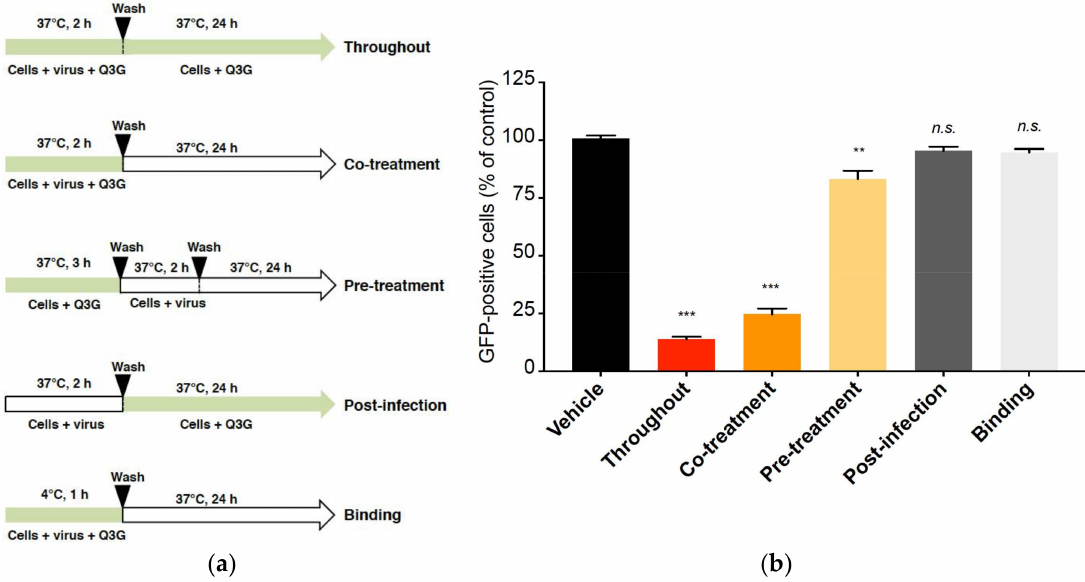
Figure 4. Q3G targets early stages of ZIKV infection. In ( a ), schematic representation of synchronised ZIKV GFP infection and Q3G treatment assays in A549 cells. Q3G (100 µ M) or vehicle were used for treatment of A549 cells throughout the infection (throughout), concurrently to virus input (co-treatment), pretreatment of naïve cells (pre-treatment), after virus exposure (post-infection) with specific washing steps and incubation periods. For viral attachment assay (binding), the test samples were used to treat A549 cells concurrently with ZIKV GFP at 4 ◦ C before washing and shifting the temperature to 37 ◦ C. The parts of arrows colored in green or white indicate respectively the presence or the absence of Q3G during the infection. In ( b ), the percentages of GFP-positive cells were determined by flow cytometry assay. The data represent the means ± SD of four independent experiments performed in triplicate, and are expressed as relative values compared to vehicle-treated